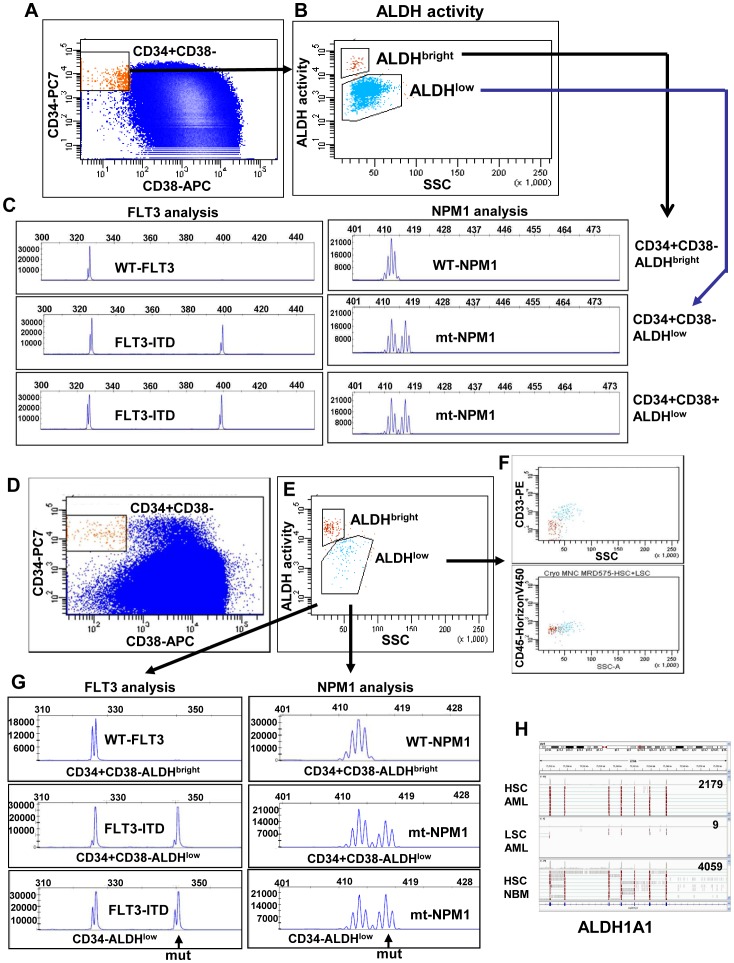
ALDHbright CD34+CD38– cells are devoid of both the FLT3 and NPM1 mutation.AML-808 contains both FLT3-ITD and mutated NPM1 and has no immunophenotypic aberrancy present. However, AML-808 can be segregated into a normal and a leukemic CD34+CD38– compartment by measuring ALDH activity (A–C). The CD34+CD38– stem cells (A, orange) segregate into two separate ALDH compartments (B). The CD34+CD38–ALDHbright cells of AML-808 do neither contain FLT3-ITD nor mutated NPM1 (C, upper panels), while the CD34+CD38-ALDHlow cells (blue) do (C, middle panel). The ALDHlow cells have both mutations (C, lower panel). AML-575 contains both FLT3-ITD and mutated NPM1. The CD34+CD38– cells (red) segregate into two separate ALDH compartments (D, middle panel). The ALDHbright (red) cells within AML-575 lack the immunophenotypic aberrancy CD33 and are low in SSC compared to the ALDHlow cells (blue)(F). The CD34+CD38-ALDHbright cells do neither contain FLT3-ITD nor mutated NPM1 (G, upper panels), while the CD34+CD38-ALDHlow cells do (G, middle panel). The ALDHlow cells have both mutations (G, lower panel). (H) CD34+CD38– HSC, CD34+CD38– LSC (purification based on CLL1+, CD34 expression and scatter properties) from AML-598, and CD34+CD38– HSC from normal BM were purified. RNA was isolated and RNA sequencing was performed. The most abundant ALDH mRNA expressed within both normal HSC fractions (AML and normal BM) was the ALDH1A1 enzyme. LSC had hardly any expression of the ALDH1A1 form. Numbers indicate the amount of ALDH1A1 reads within that fraction.